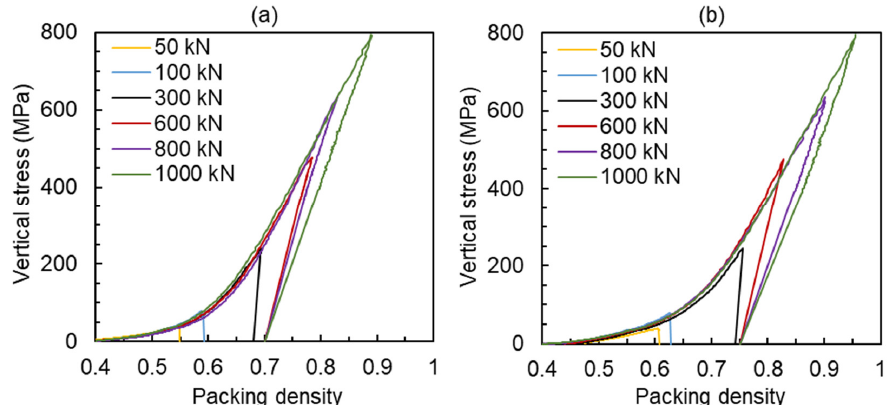
Figure 3. Relationship between the vertical stress and the packing density for different compressive forces applied for the ( a ) Itabira and ( b ) Carajás samples in the narrow size range of 150–125 µm.